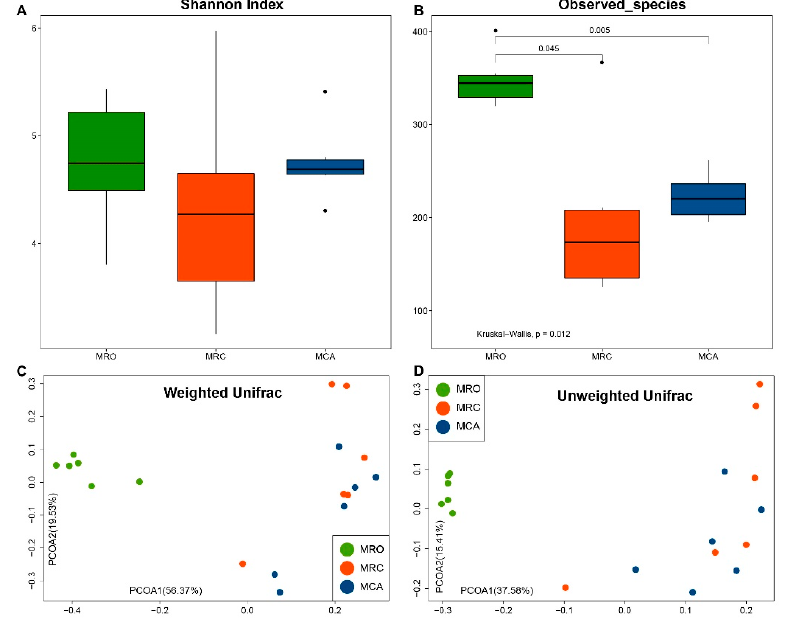
Figure 2. The early supplementary solid diet impacted on Alpha and Beta diversity of rumen microbiome in goat kids. ( A – B ) The Shannon Index and Observed species. Alpha diversity of the rumen microbial data were tested using the Kruskal-Wallis test and a post-hoc Dunn Kruskal-Wallis multiple comparison, and the Bonferroni method was used for p value correction. Principal coordinate analysis (PCoA) of the community membership based on the weighted ( C ) and unweighted ( D ) UniFrac distance are depicted with the green cycles as the MROgroup, the red cycles as the MRC group and the blue cycles as the MCA group. Although diversity (Shannon index) was not different ( p = 0.372), significance of microbial richness was observed among MRO, MRC and MCA groups of rumen samples ( p = 0.012). Significances in community structure among the 3 groups were detected (Weighted Unifrac ANOSIM, R = 0.68, p < 0.05; UnWeighted Unifrac ANOSIM, R = 0.69, p = 0.001). The MRO formed a distinct cluster on the left side, while the MRC and MCA were closely clustered on the right side of the PCoA plot. MRO = milk replacer; MRC = milk replacer + concentrate; MCA = milk replacer + concentrate + alfalfa; ANOSIM: Analysis of similarity.